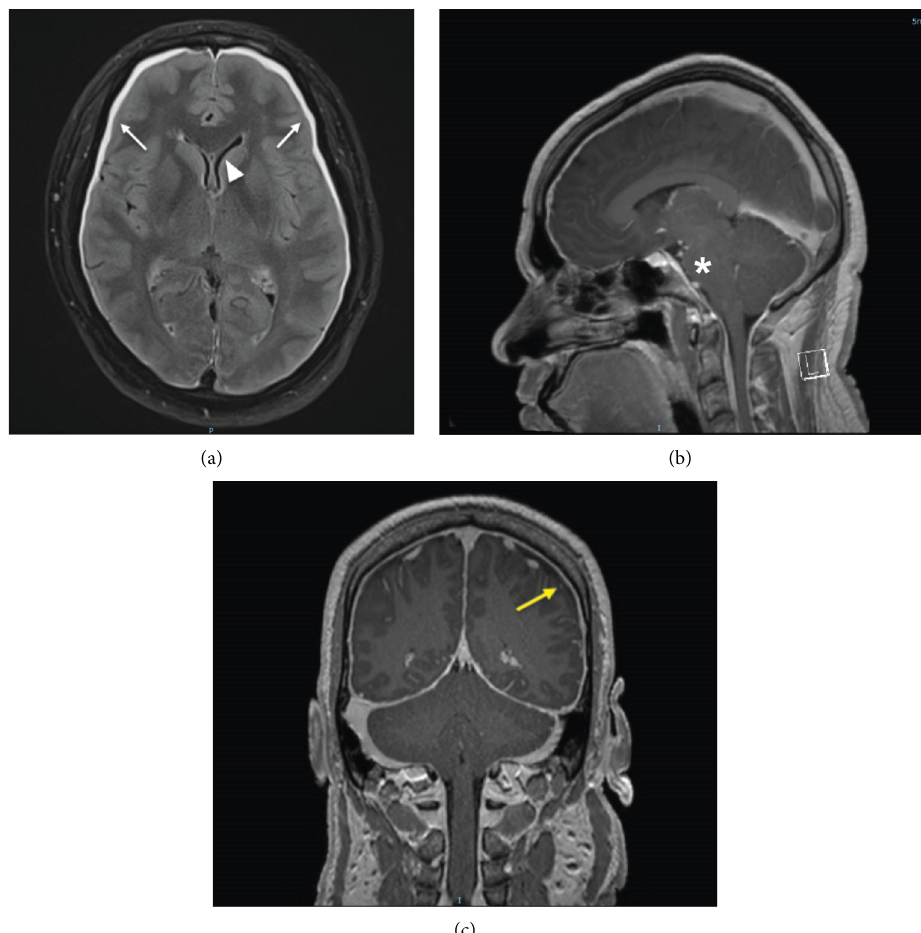
Figure 1: MRI of the brain showing features of intracranial hypotension. (a) FLAIR: bilateral subdural hygromas (white arrows) and slit-like ventricle (white arrowhead). (b, c) Post-contrast: reduced pre-pontine space (asterisk) and diffuse pachymeningeal enhancement (yellow